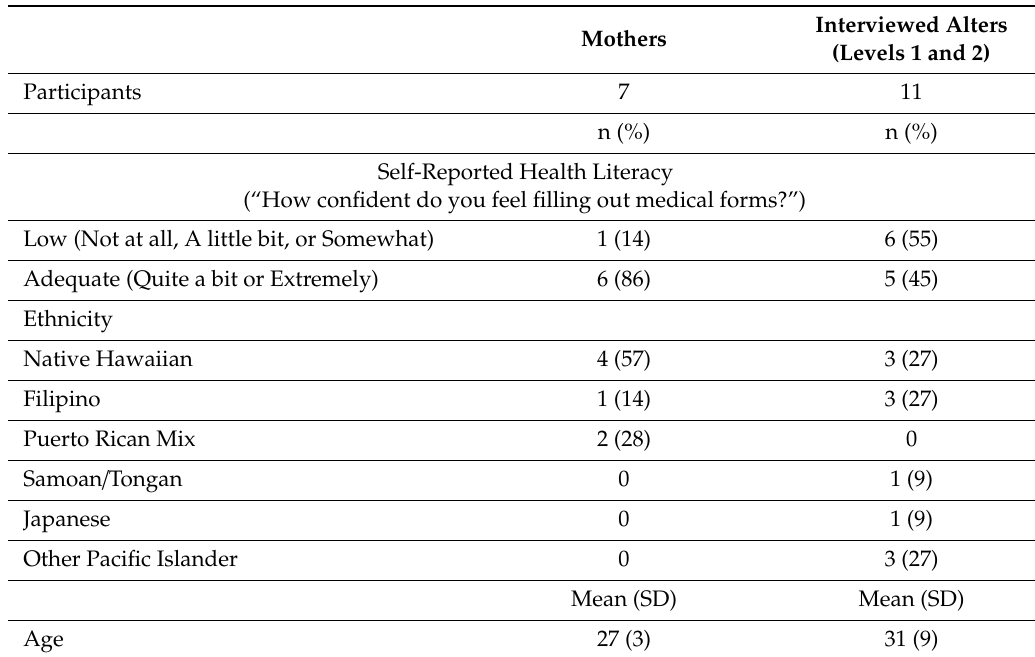
Table 2. Health literacy and ethnicity of all individuals in the networks (Numbers sum to < 100% due to